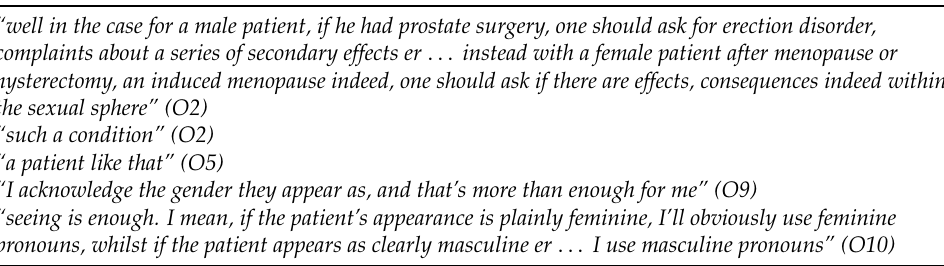
Table 4. Deadnaming and